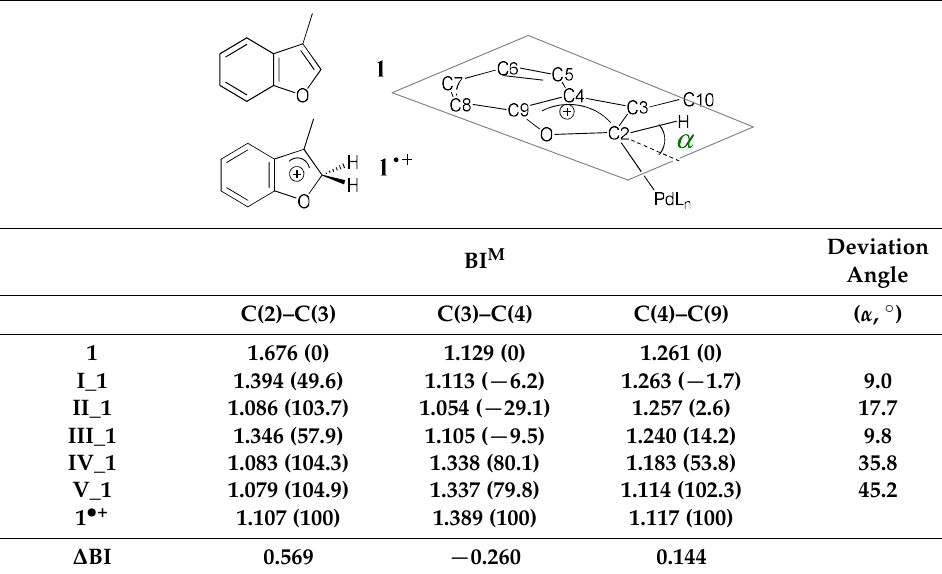
Table 2. Mayer bond indices (BI M s), n 0 values (% in parenthesis), and deviation angles ( α , °) of ipso hydrogen in the optimized adduct states a .